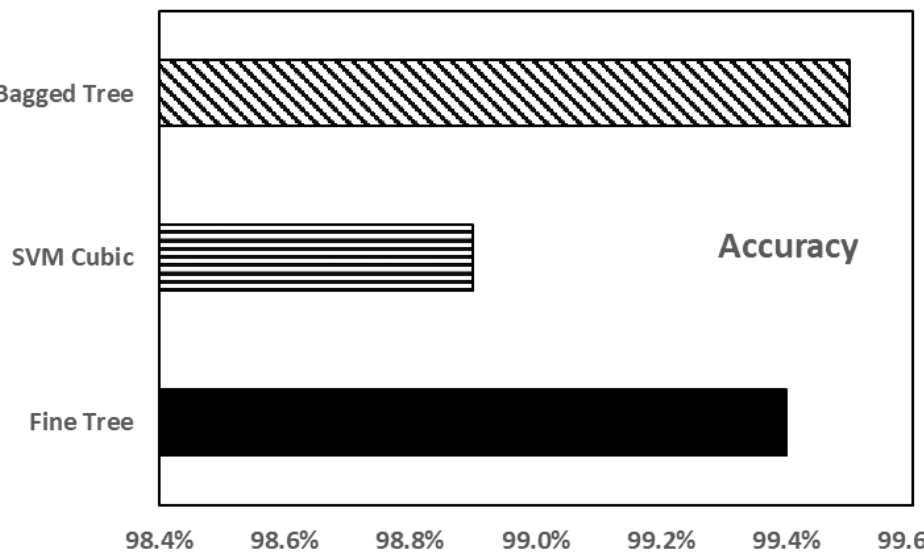
Figure 10. Accuracy of the different SVM